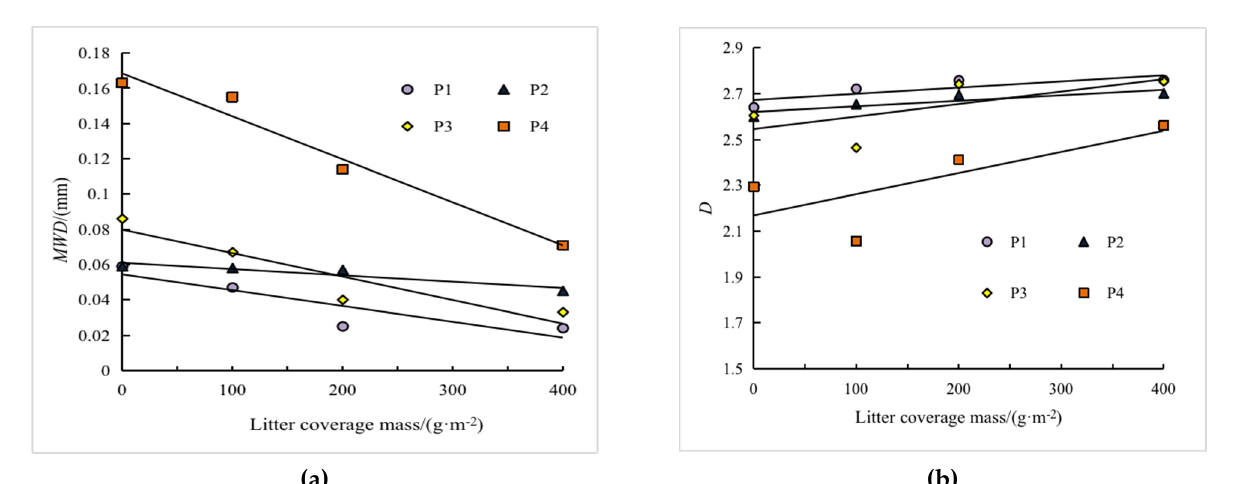
Figure 6. The relationship between eroded sediment separation characteristic parameters and litter coverage mass. Relationship between MWD ( a ), D ( b ) and litter coverage mass under different slopes and rainfall intensities. P1—slope of 5° and rainfall intensity of 60 mm·h − 1 ; P2—slope of 10° and rainfall intensity of 60 mm·h − 1 ; P3—slope of 5° and rainfall intensity of 120 mm·h − 1 ; P4—slope of 10° and rainfall intensity of 120 mm·h − 1 . Table 5. Eroded sediment separation characteristic parameters as function of litter coverage mass.